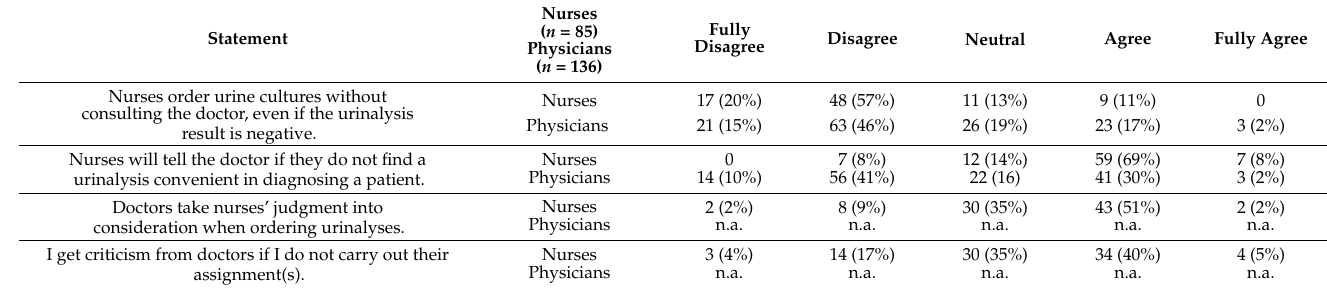
Table 5. Communication factors related to reducing inappropriate urine